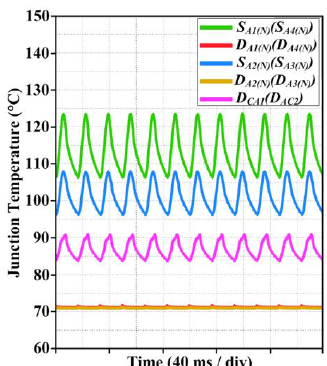
= 20 kHz and R = 0.255 K / Figure 8. Junction temperatures of the power devices in the NPC inverter at the rated power when f sw th(h − a) = 20 kHz and R th(h-a) = 0.255 K/W.